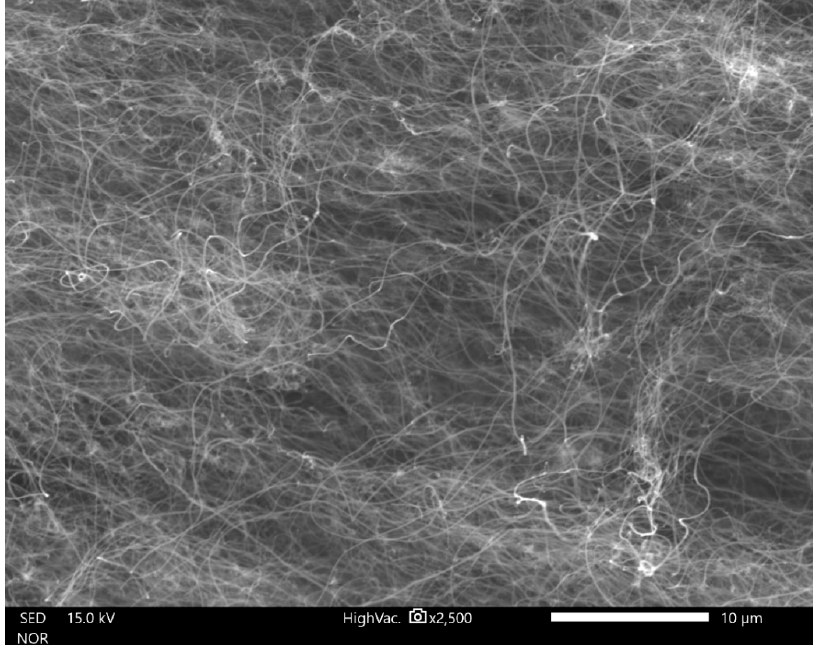
Figure 3. SEM image of ferromagnetic MWCNTs—sample no. 4 (optimum flow velocity).